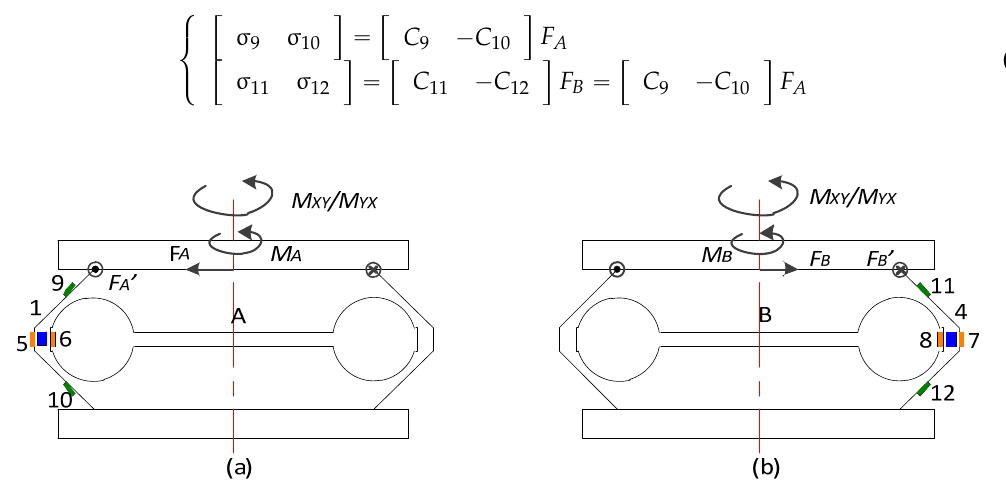
Figure A5. ( a ) Elastic Beam A under Z axial moment; ( b ) Elastic Beam B under Z axial moment.